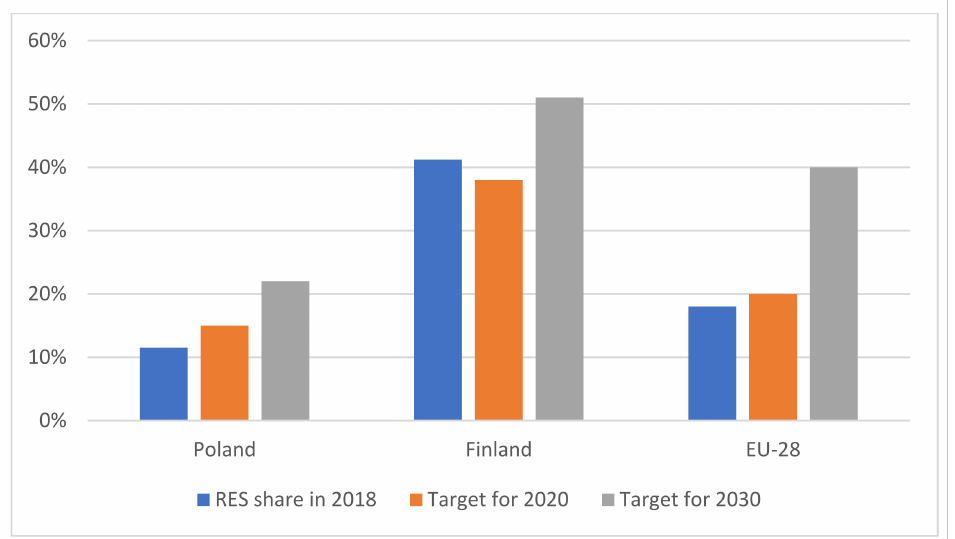
Figure 1. Share of renewables in final gross consumption. Own calculations based on